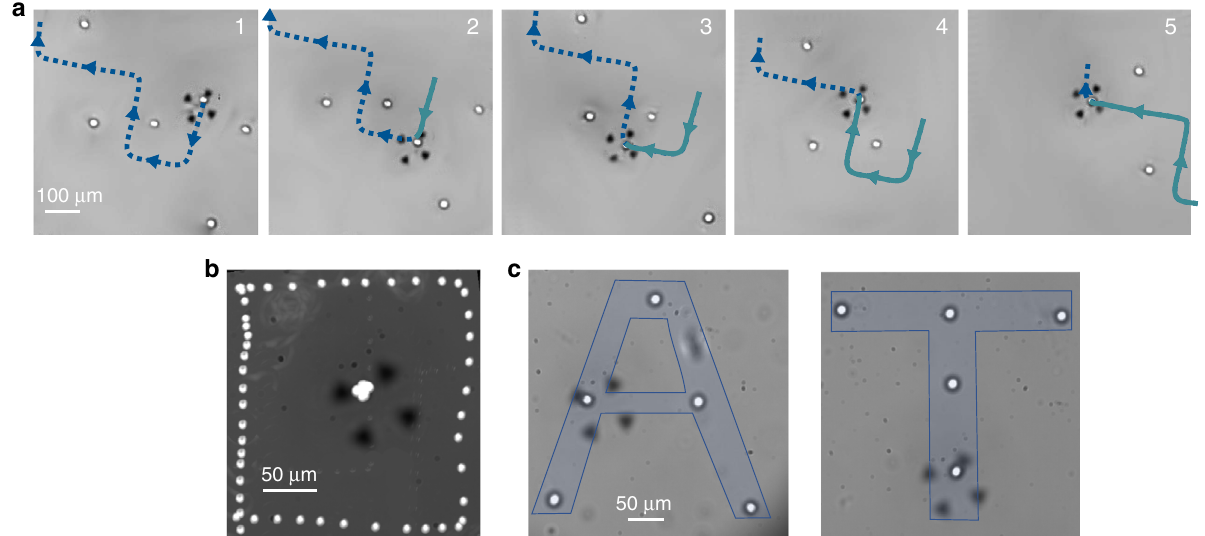
Fig. 3 Cells ’ manipulation with selective acoustical tweezers. a Stack of images illustrating the selective manipulation of a human breast cancer cell (MDA-MB-231) of radius 7 ± 1 μ m between other cells. The blue dotted line and green continuous line show, respectively, the future and past path followed by the cell (see also Supplementary Movie 2). b Image illustrating the square relative motion of a trapped cell 1 of 7 ± 1 μ m (located in the center of the picture) around another cell 2 obtained by superimposing the images of the two cells in the frame of reference of the trapped cell (see also Supplementary Movie 3). In this frame of reference, the successive positions of cell 2 form a square. For the sake of clarity other cells appearing in the fi eld of view have been removed. c Manipulation of ten MDA cells (average radius 9 μ m to form the letters A and T of the words Acoustical Tweezers). This alignment procedure was reproduced twice. Note that in these pictures the focus is voluntarily left under-focused to improve contrast of the